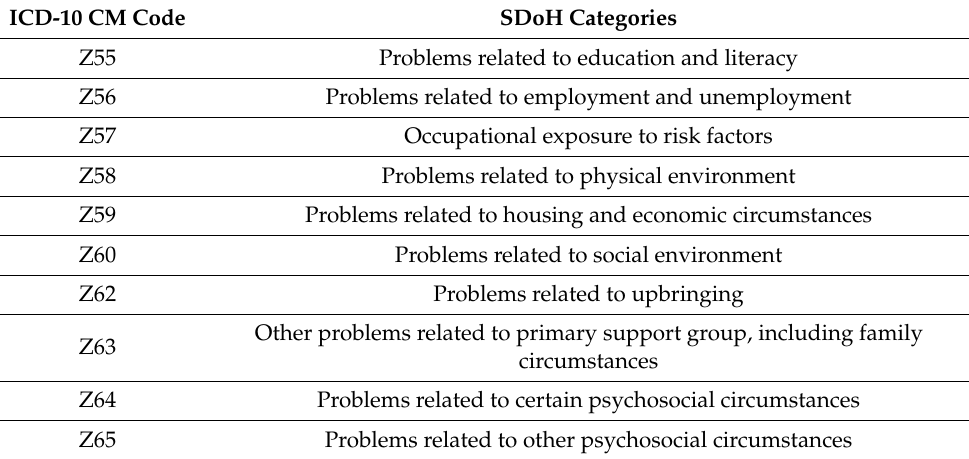
Table 1. International Classification of Disease (ICD) Z codes for SDOH